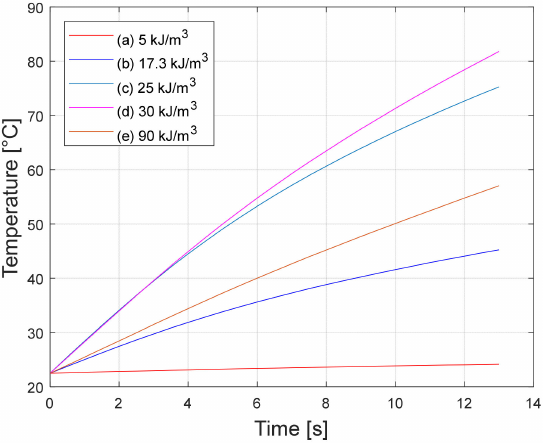
Figure 16. Comparison of time–temperature curves at different K eff . at magnetic field parameters being f = 281 kHz and H = 7.83 kA/m.